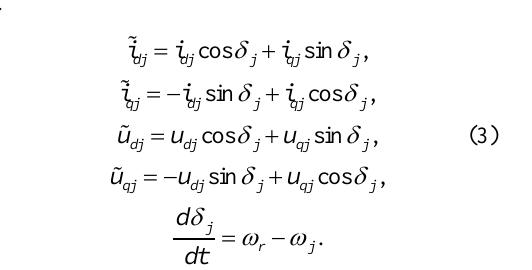
Fig. 5. Equivalent circuits for a) loads, b) reactors